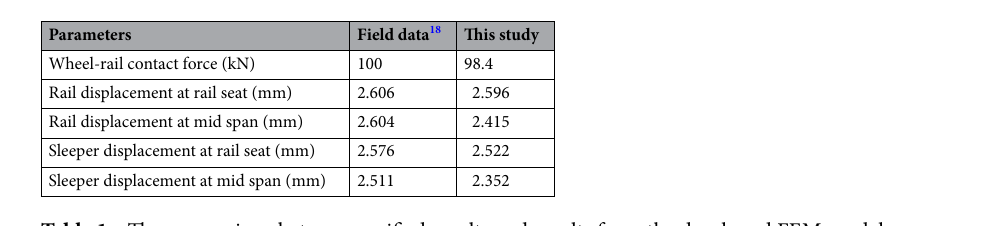
Table 1. The comparison between verified results and results from the developed FEM model.